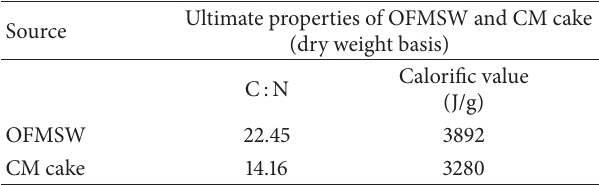
Table 3: Ultimate properties of OFMSW and CM